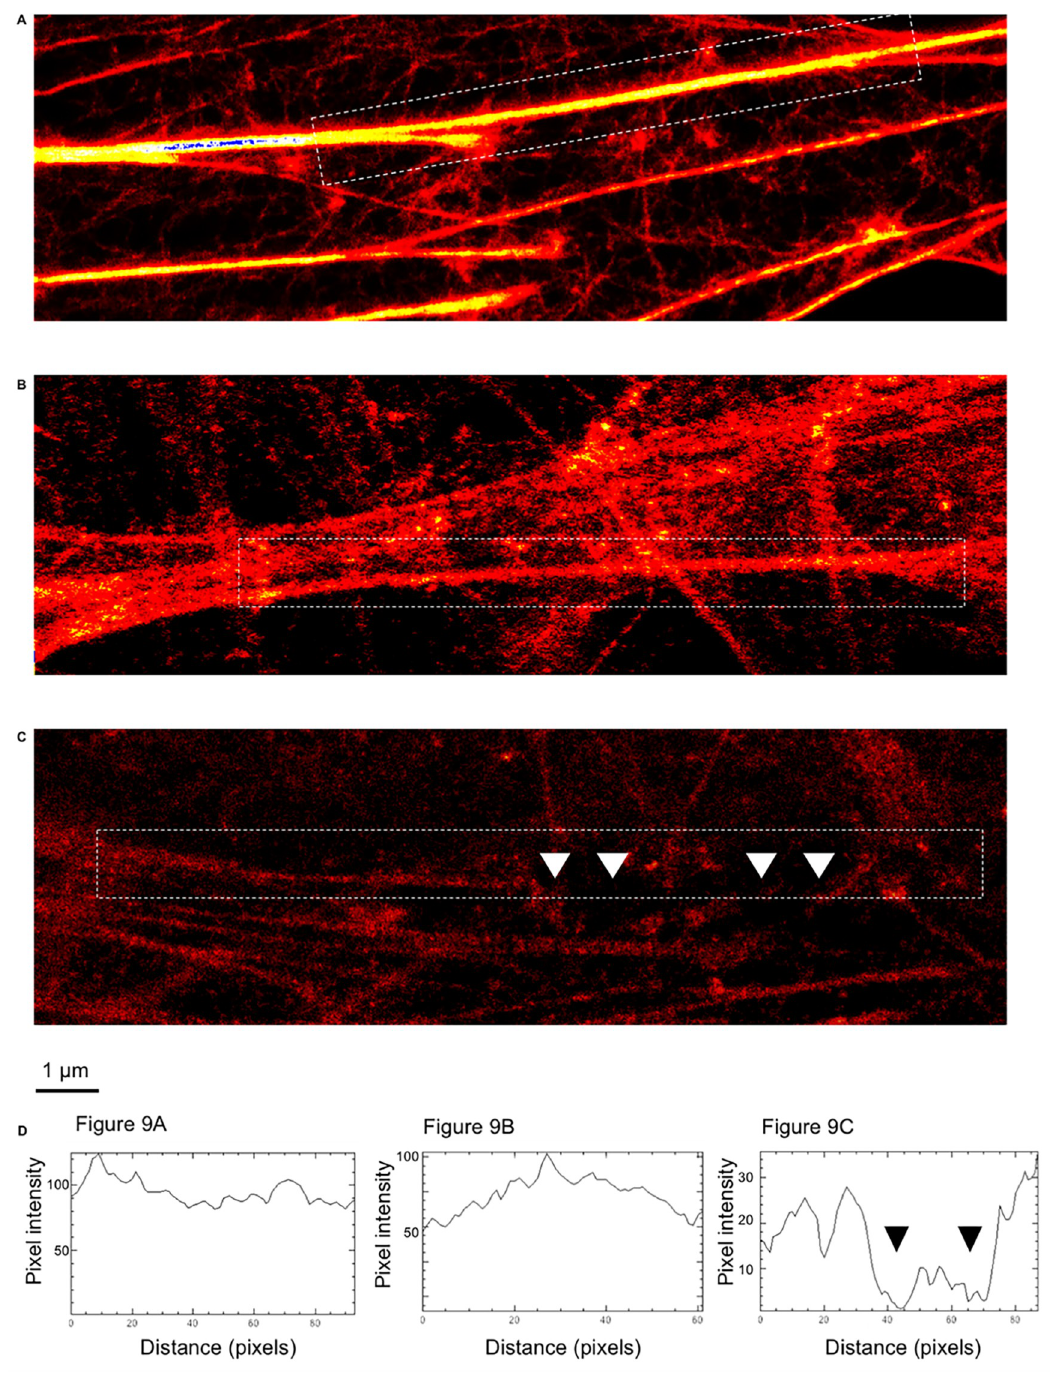
Fig 9. Disruption of neuronal β -actin filaments imaged by STED super-resolution microscopy. Immunofluorescence STED super-resolution microscopy analysis showing β -actin filaments (red) within neurons uninfected ( A ), infected with TIGR4 Δ rrgA - srtD Δ ply ( B ) and TIGR4 ( C ). ( D ) Intensity profiles of the β -actin filaments selected within white dashed rectangles; fluorescent intensity profile measurement performed with the function of Image J Analyze/Plot Profile . the intensity profiles shown in D are representatives of the whole imaging experiment (for each experimental group, 25 neuronal cells were imaged). White arrows in C point towards gaps of β -actin filaments that correspond to the drop of fluorescent intensity measured in the intensity profile graph (black arrows, third graph from the